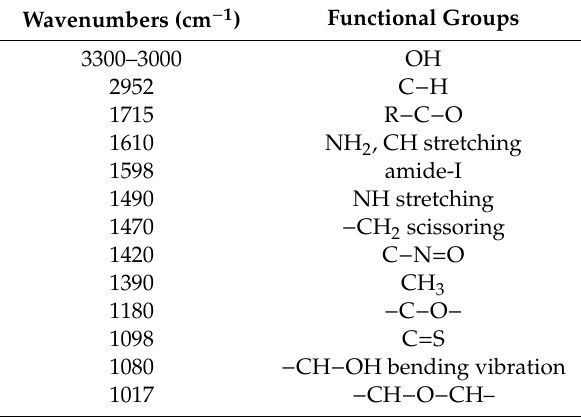
Figure 4. FTIR spectra of CPN.